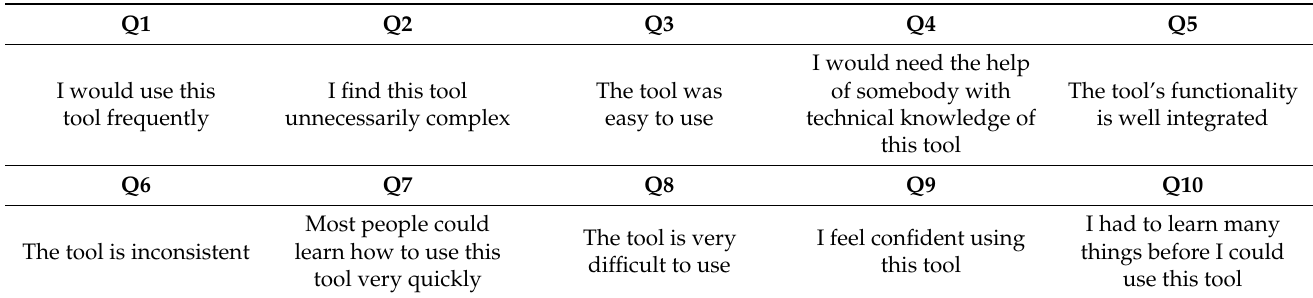
Table 6. System Usability Scale (SUS) questionnaire [41].